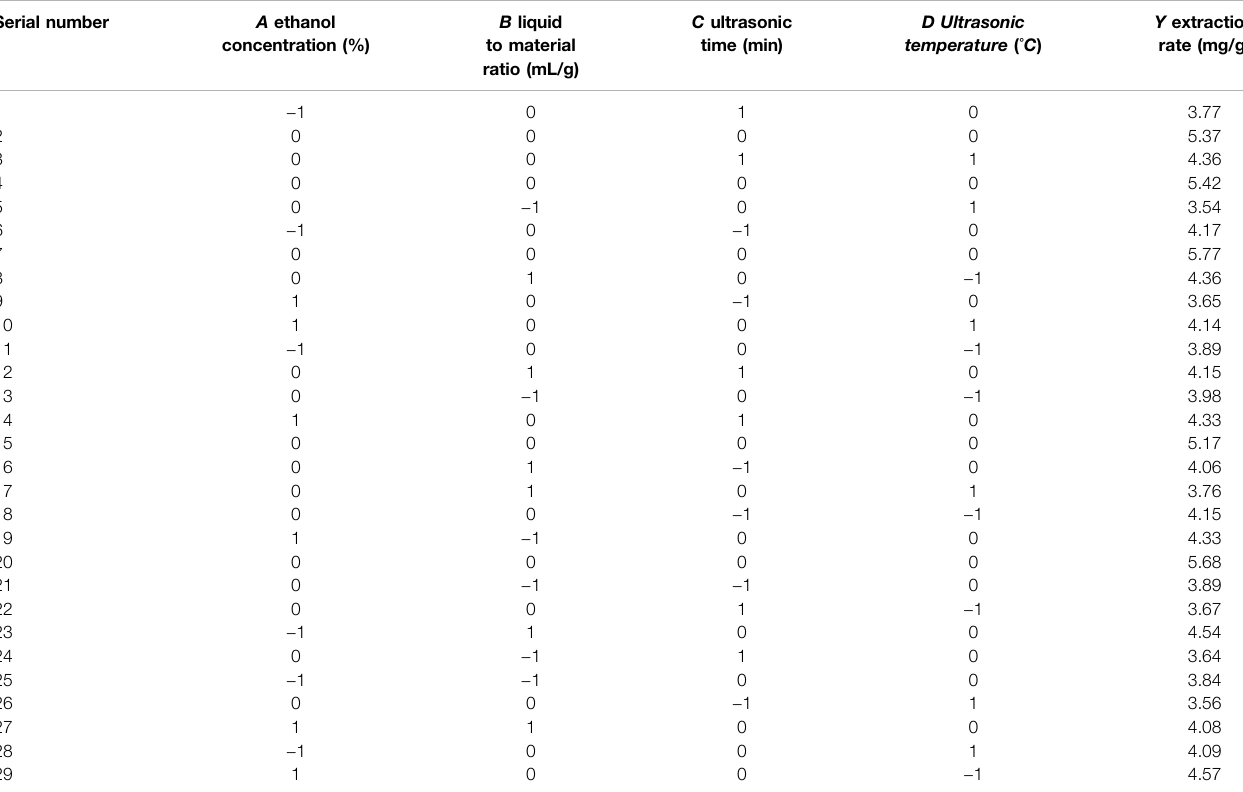
TABLE 1 | Response surface experimental design and results.